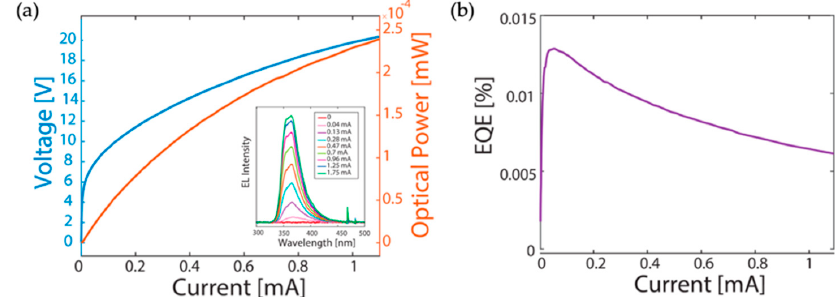
Figure 7. ( a ) I ‐ V characteristics and the light output power vs. the injection current for AlGaN nanowire UV LEDs on graphene. Inset: EL spectra under different injection currents (from 0 mA to 1.75